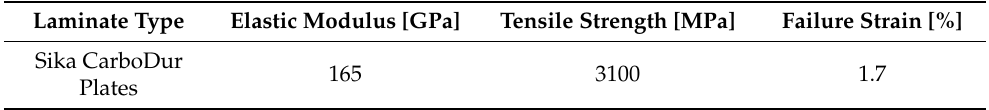
Table 3. CFRP laminate mechanical characteristics.